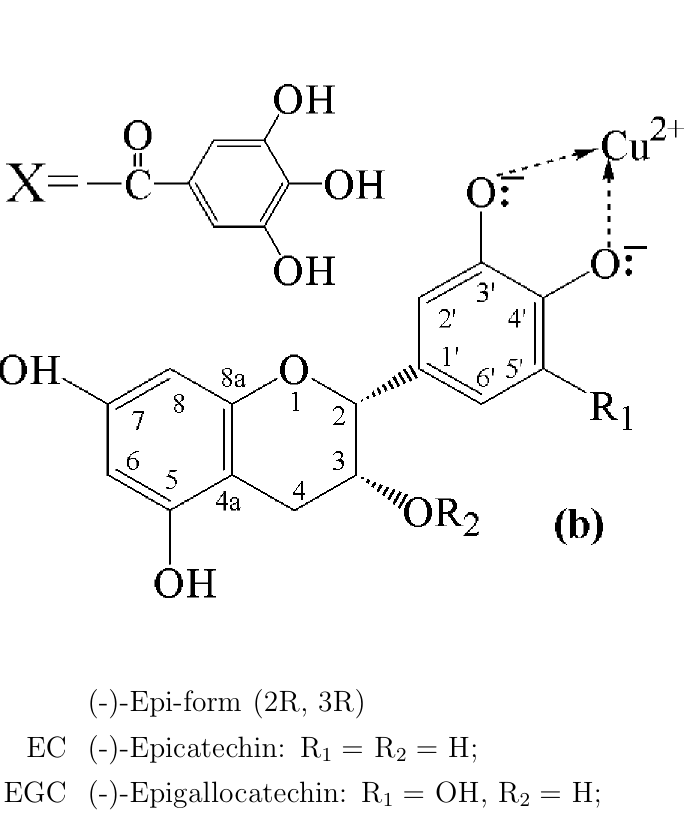
Fig. 1 Chemical structures of: a|epicatechins; b|epicatechin-copper